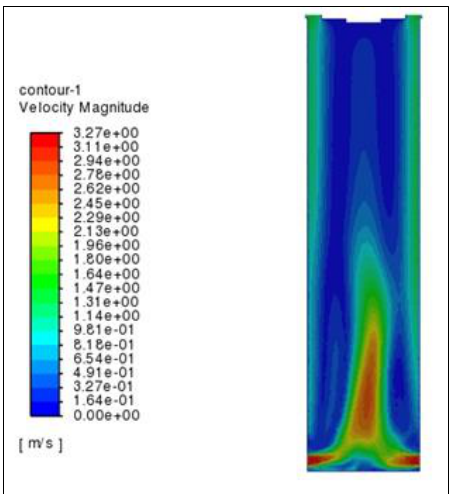
Figure 8. Air velocity nephogram.